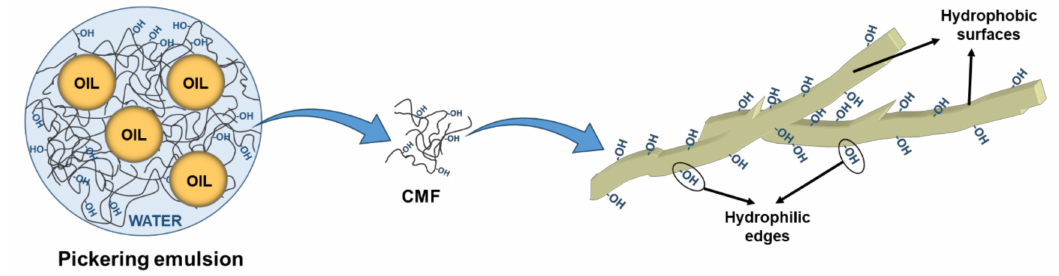
Figure 3. Role of CMF in Pickering emulsions.